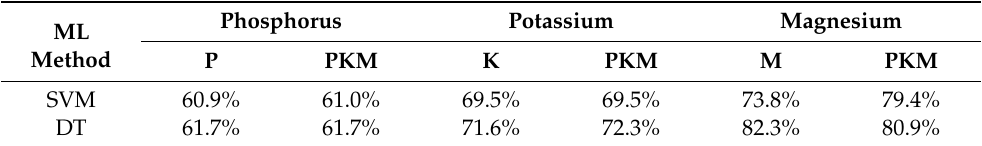
Table 6. Results of the soil properties prediction using a single and multi-component class strategy.